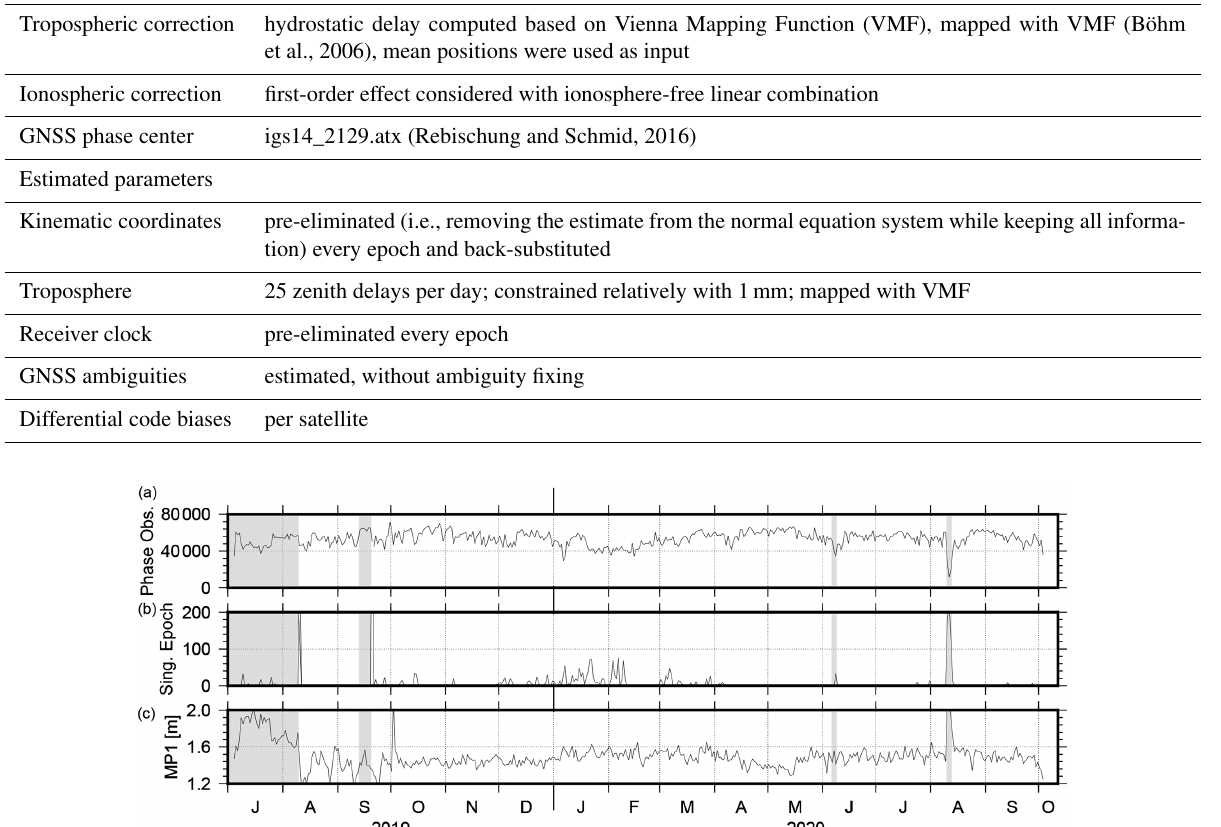
Figure 3. Number of phase observations per day used in the final adjustment (a) , number of singular epochs per day (i.e., epochs with fewer than four observations, based on 30s sampling, b ) and daily TEQC-based multipath MP1 values (c) ; periods of harbor stays and re-supply are shaded in